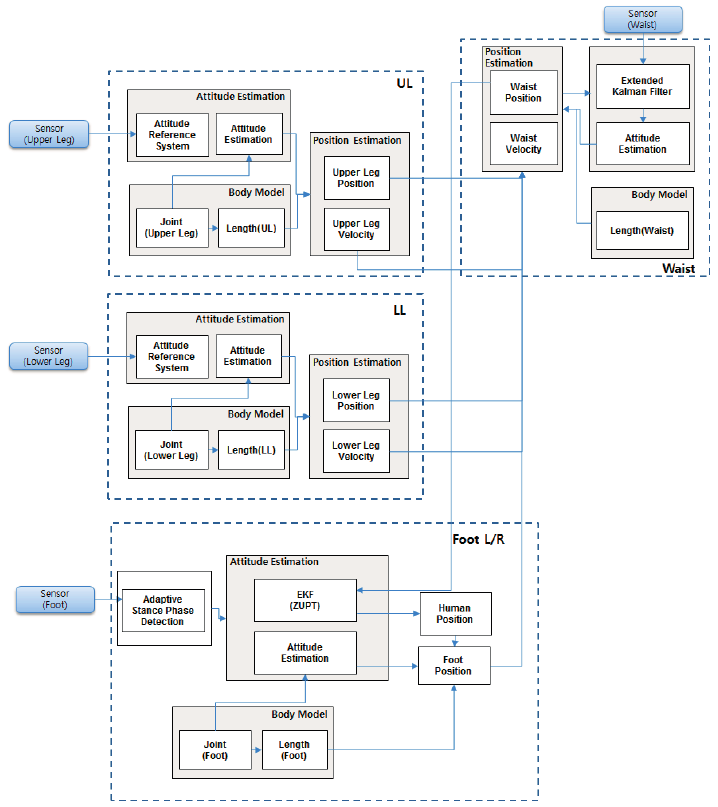
Figure 10. Flowchart of kinematic model and PDR fusion